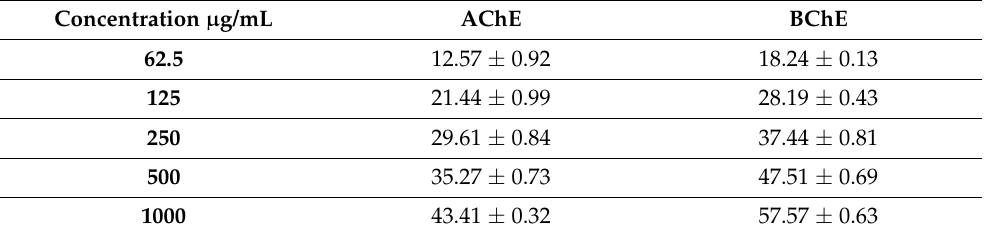
Table 5. In vitro cholinesterase potential of FeNPs against AChE and BChE